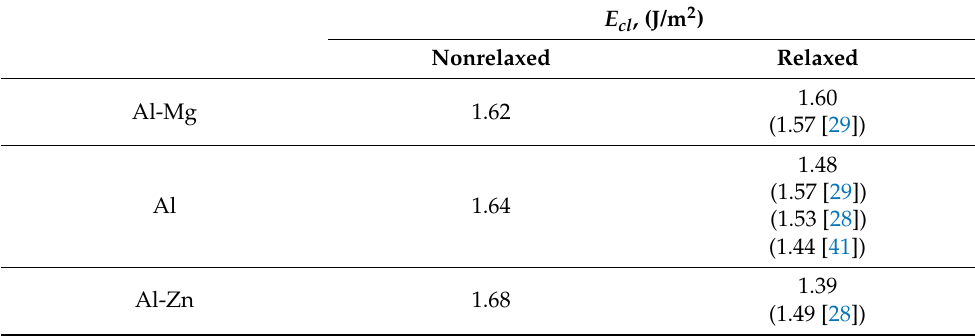
Table 4. Cleavage energy for the ∑ 5{013}[100] GB in Al and Al alloys. The results of previous calculations are shown in